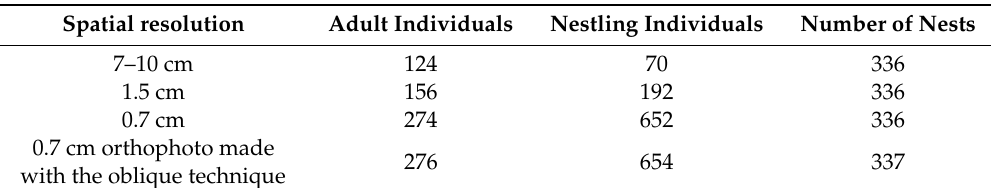
Table 5. Comparative results. The number of detected individuals and nests in the observed area based on orthophotos with di ff erent spatial resolutions.